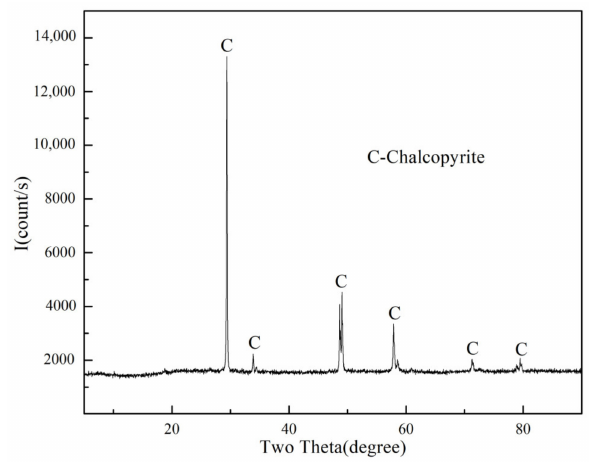
Figure 1. XRD spectra of the chalcopyrite